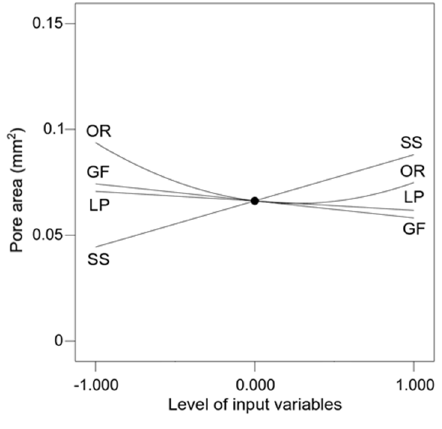
Figure 11. The influence of different processing parameters on the pore area.